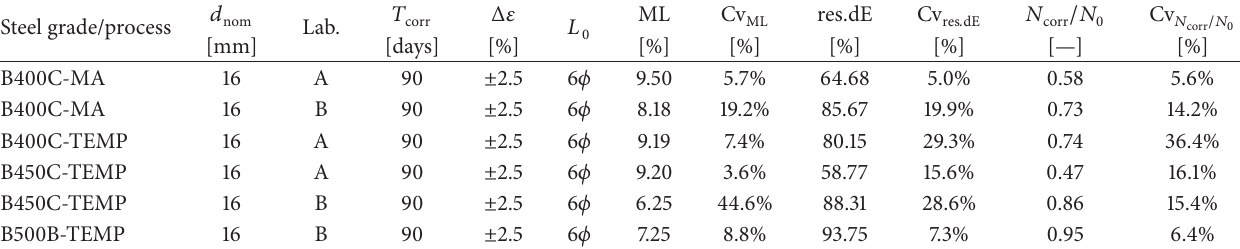
Table 4: Average values and coefficient of variation of residual mechanical properties of corroded bars, cyclic tests.